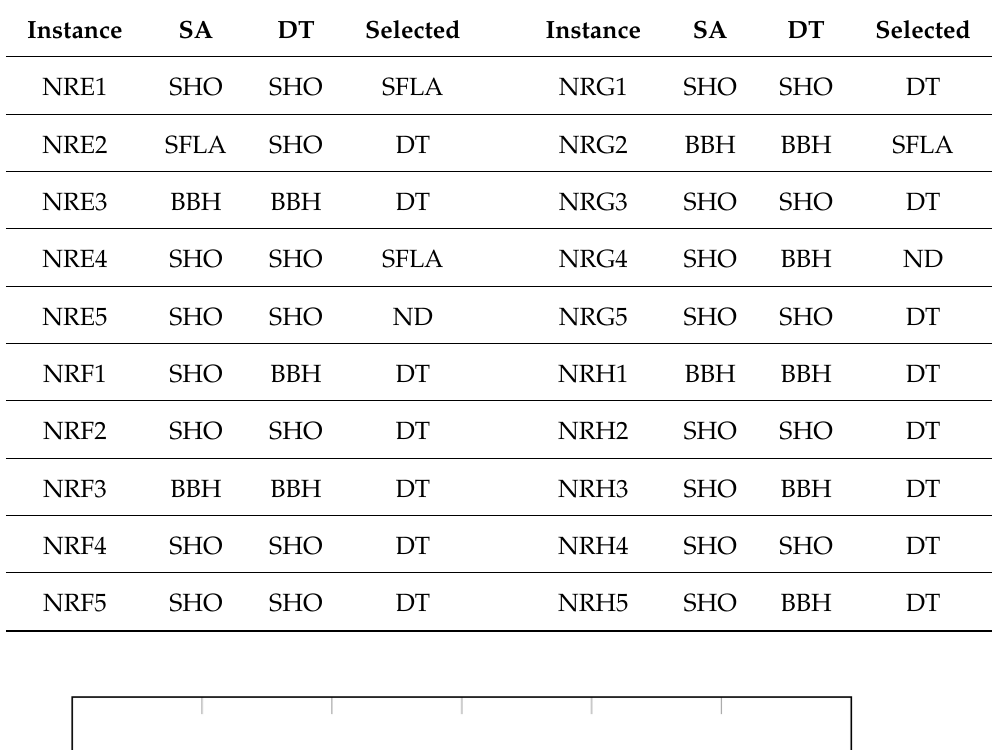
Table 7. Results algorithm comparison.